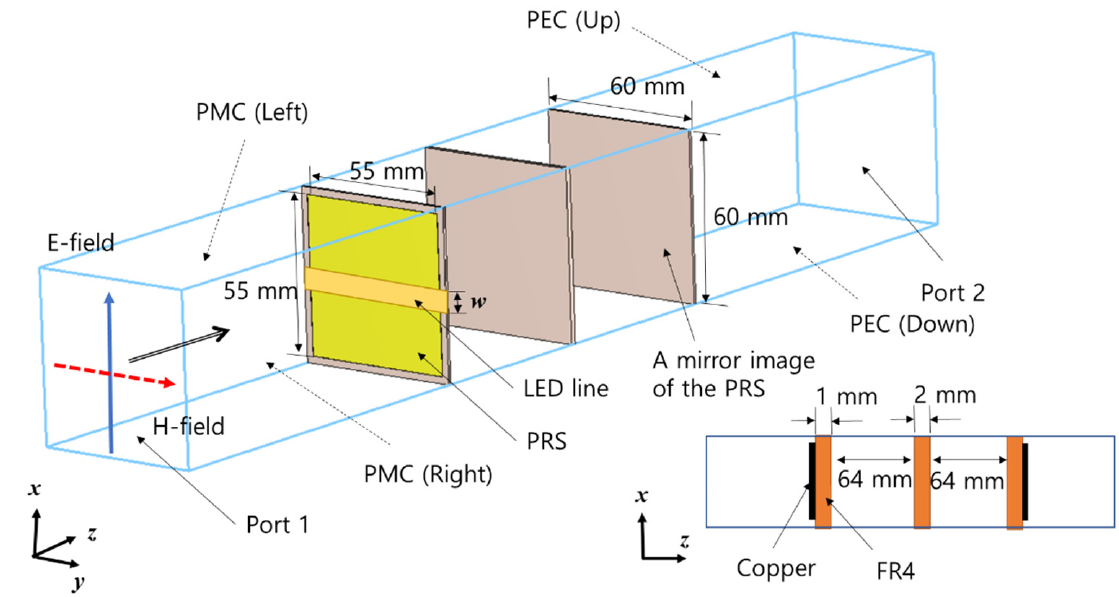
Figure 4. Unit cell simulation structure.